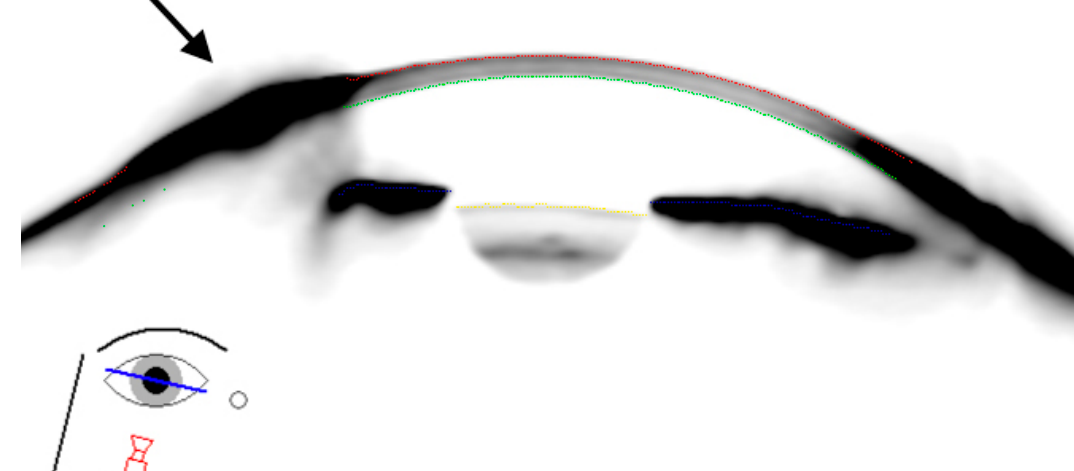
Figure 6. A Pentacam–Scheimpflug image (inverted colours) shows a nasal pterygium in form of corneal thickening (arrow) of the left eye of a 62-year-old male with a horizontal length of 3.5 mm before irradiation. By merging 25 Scheimpflug images, the 3D model of the anterior eye segment and all other calculations are generated.